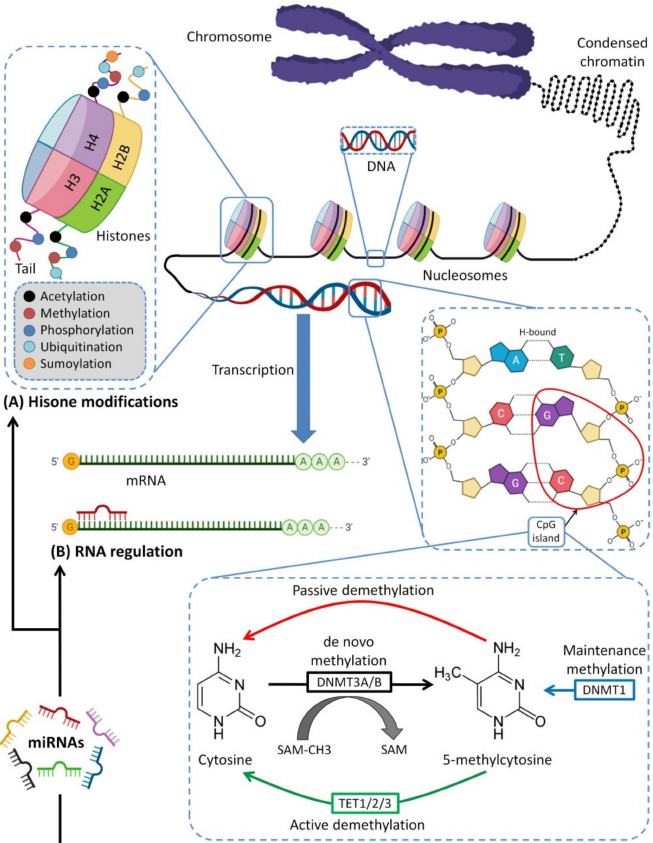
Figure 7. A schematic diagram of the epigenetic mechanisms that can be modulated by miRNAs. Without changing the DNA sequence, miRNAs affect gene expression post-transcriptionally, resulting in altered protein levels of target mRNAs. This effect, known as epigenetic regulation, can occur through three major epigenetic mechanisms, including DNA methylation, histone modifications and RNA regulation. ( A ) Rearrangement of the core histone proteins (H2A, H2B, H3 and H4) involved in chromatin reorganization and regulation of transcription, which come together to form one nucleosome, called histone modifications. These covalent modifications are driven by post- translational addition or removal of acetyl, methyl, phosphate, ubiquityl and sumoyl that attach to the tails of histone proteins. miRNAs could regulate histone modifications by targeting histone- modifying enzymes such as deacetylase and demethylases. ( B ) RNA regulation is a less well-known epigenetic mechanism and occurs through several models, including miRNA regulation of gene expression upon interaction with targeted mRNAs, as shown in Figure 5. Moreover, it has been shown that RNA regulation is involved in epigenetics by modulating chromatin structure. ( C ) The most widely discovered epigenetic mechanism is DNA methylation. It predominantly occurs on cytosine-phosphate-guanine (CpG) dinucleotides called CpG islands (CGIs). DNA methylation patterns start with DNA methyltransferase (DNMTs) enzymes transferring a methyl group from the methyl donor S-adenyl methionine (SAM), which is derived from ATP and methionine, to the fifth carbon of cytosine (on a CGI) to produce 5-methylcytosine (5-mC). DNA methylation patterns involve four processes: (1) adding a methyl group to unmethylated DNA by DNMT3A and DNMT3B (de novo methylation); (2) preserving DNA methylation by DNMT1 during cellular DNA replication (maintenance methylation); (3) inhibition of maintenance methylation (passive demethylation); (4) oxidation and deamination of 5-mC to obtain an unmodified cytosine by the ten–eleven translocation (TET) enzymes 1/2/3. miRNAs can directly target DNMTs (e.g., DNMT3A and DNMT3B) and methyl-CpG binding proteins (e.g., MeCP2 and MBD2), resulting in DNA methylations [674–681]. Created with BioRender.com, accessed on 22 April